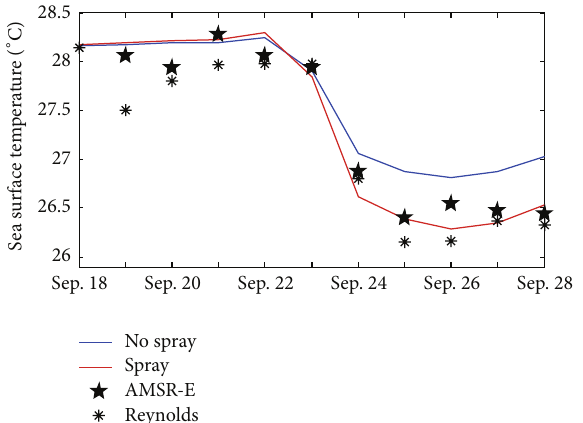
Figure 5: Variation of daily averaged SST during the passage of typhoon Yagi. Red and blue curves represent results of test including spray effect (Test 1) and excluding spray effect (Test 2), respectively. Black pentacle line and black star line represent AMSR-E and Reynolds SST, respectively.